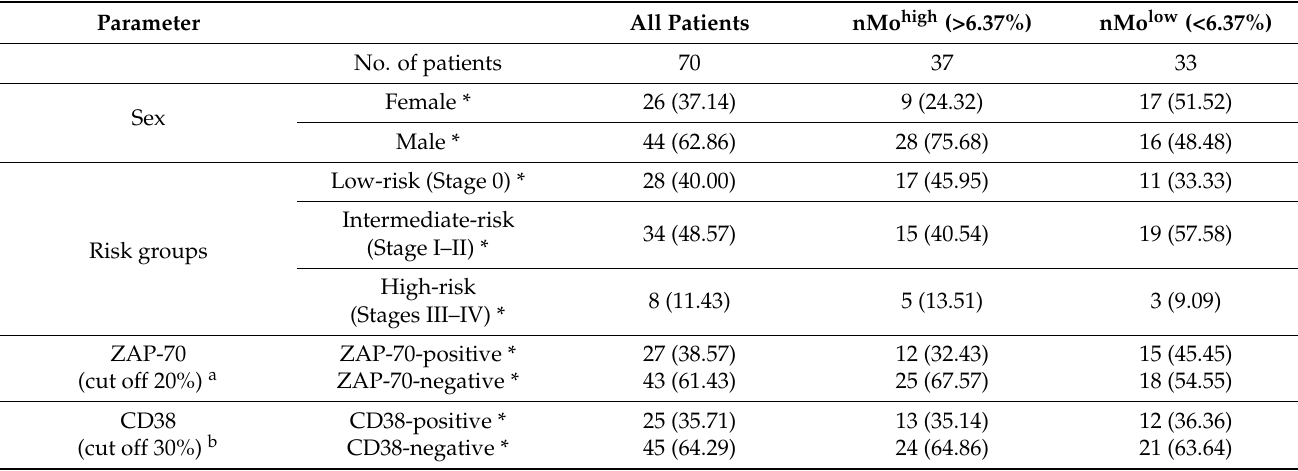
Table 1. Clinical and laboratory characteristic of CLL patients in groups with high and low percent- ages of SLAN-positive non-classical monocytes